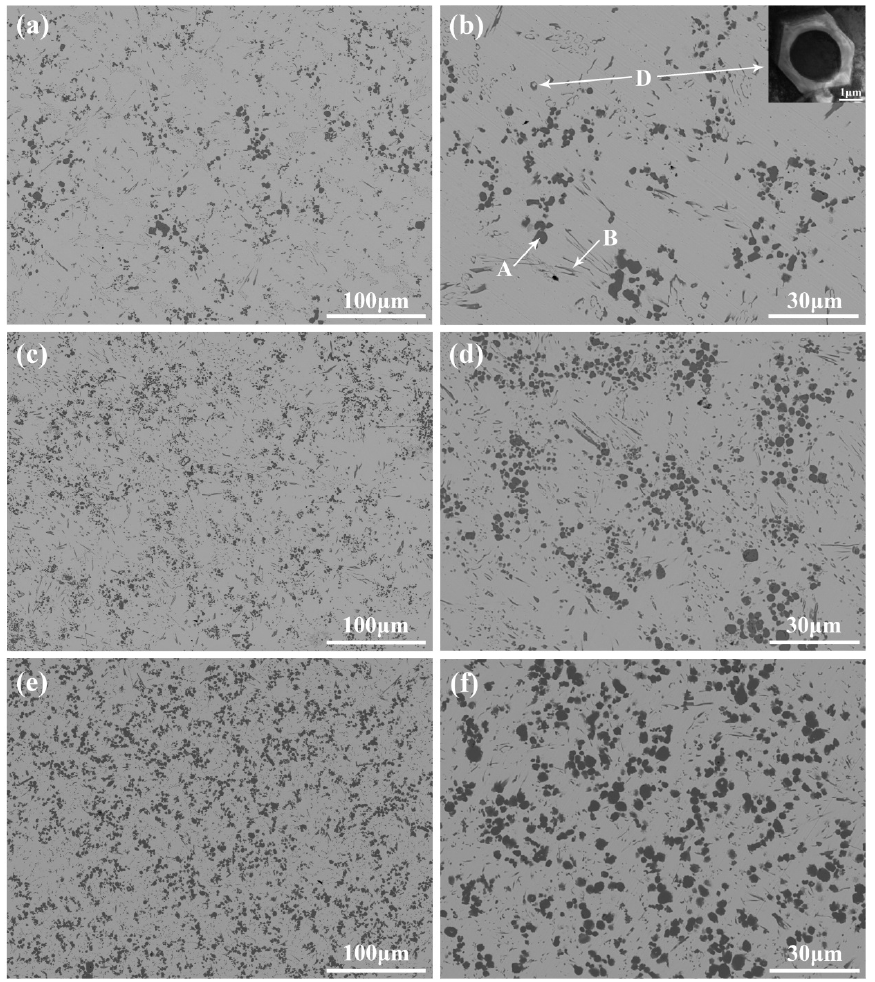
Figure 1. Microstructure of the as ‐ cast composites prepared by Ti–SiC reaction in Cu melts. ( a , b ) Cu ‐ 4.86Ti ‐ 1Si ‐ 0.43C; ( c , d ) Cu ‐ 6.8Ti ‐ 1.4Si ‐ 0.6C; ( e , f ) Cu ‐ 9.72Ti ‐ 2Si ‐ 0.86C. (A ‐ TiC; B ‐ Ti 5 Si 3 ; D ‐ Cu@TixSiy).